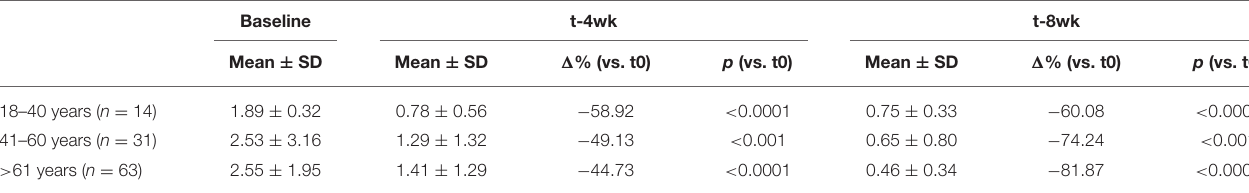
TABLE 5 | Serum levels of TMAO before and after 4-week and 8-week treatment with Taurisolo ® in study participants stratified for age.